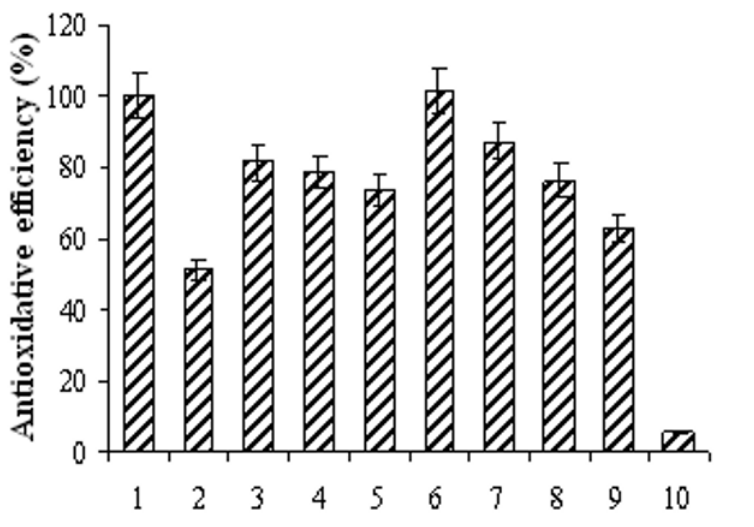
Figure 8. Antioxidative effect of selected phenolic acids and herbs on guanine oxidation: 1. blank dsDNA signal, 2. Fenton’s mixture, 3. Gallic acid 10 -4 mol L -1 , 4. Caffeic acid 10 -4 mol L -1 , 5. Trolox 10 -4 mol L -1 , 6. Black tea 2.5% w/v, 7. Green tea 2.5% w/v, 8. Origanum dictamnus 2.5% w/v, 9. Aloysia triphylla 2.5% w/v, 10. Sideritis syriaca 2.5%